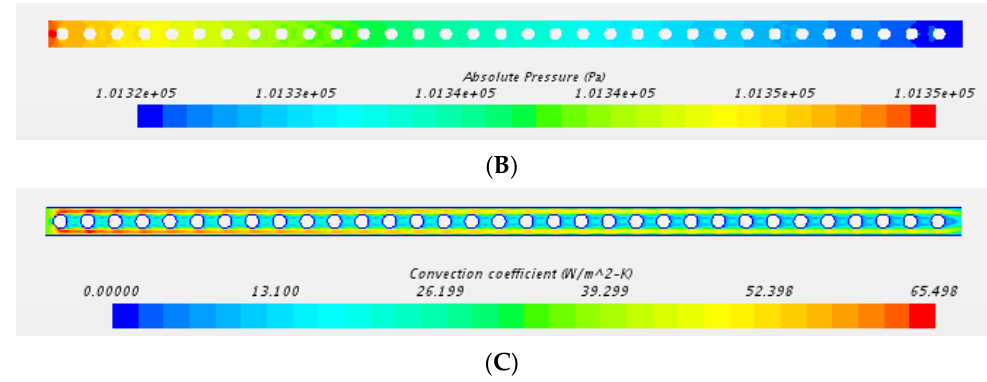
Figure 3. ( A ) Comparison of the CFD model with the analytical method, modelling cooling of air by coils perpendicular to the flow direction. The graph shows the temperature drop along channel length matches well between the analytical and CFD models. ( B ) The result shows the pressure drop along channel length from CFD. The pressure drop is uniform across channel width and decreases gradually along the channel length. The analytical model used for pressure drop calculation can be found in the supplemental section. ( C ) The result shows the convection coefficient along channel length from CFD. Higher convection coefficient occurs around vicinity of coils due to higher velocities in these regions. The analytical model used for convection coefficient calculation can be found in the supplemental section.